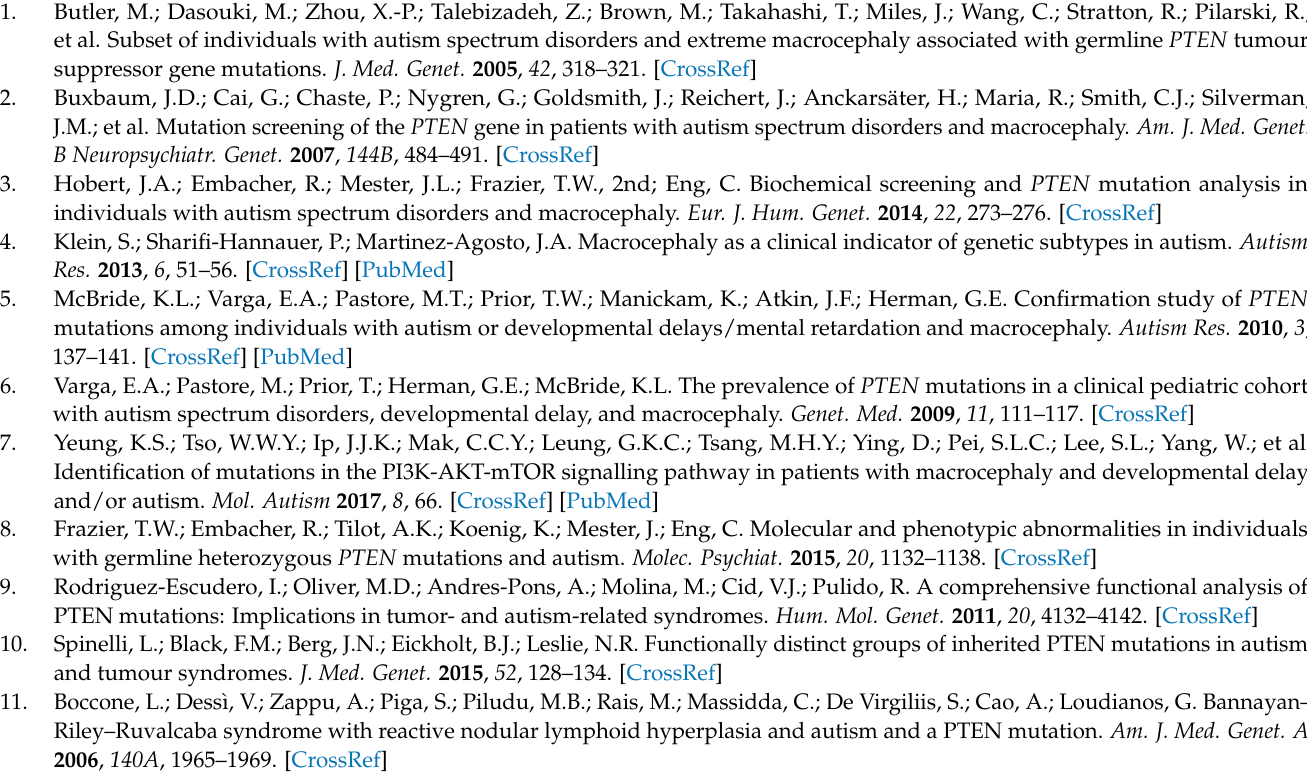
Table S3: Statistics for post-mortem